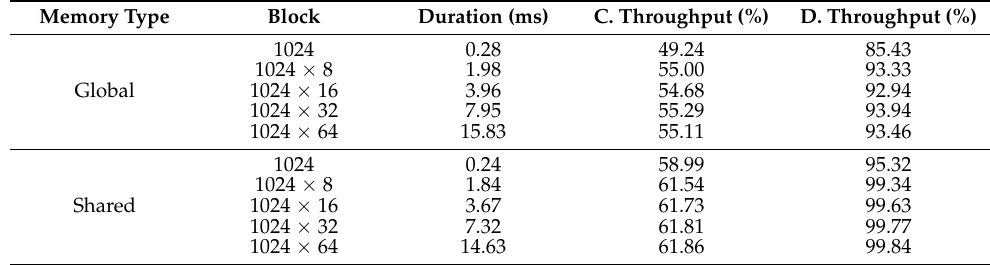
Table 5. Performance as the number of blocks increases (C.: compute, M.: memory, thread: